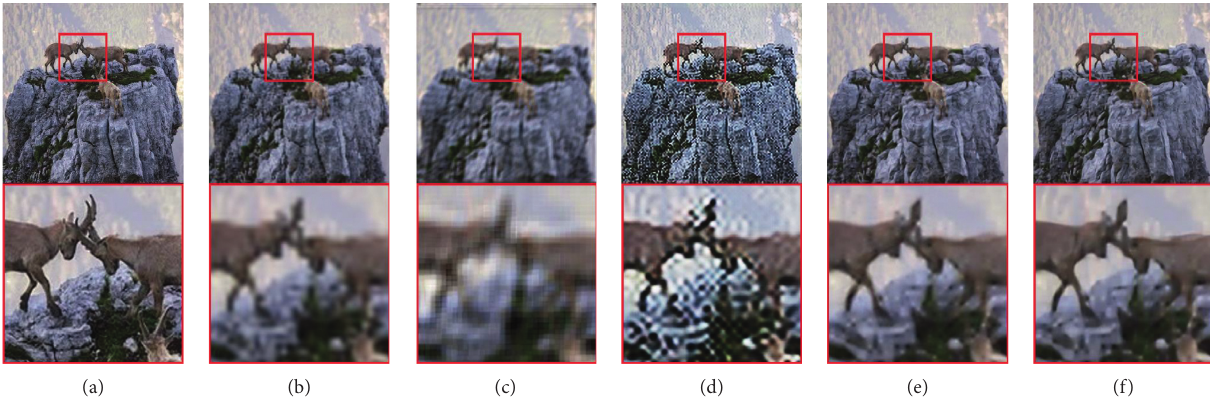
Figure 8: Super-resolution results of the “mountain” image with magnification factor 4: (a) original high-resolution image; (b) result reconstructed by SRCNN; (c) result reconstructed by FSRCNN; (d) result reconstructed by SRGAN; (e) result reconstructed by RDN; (f) result reconstructed by our